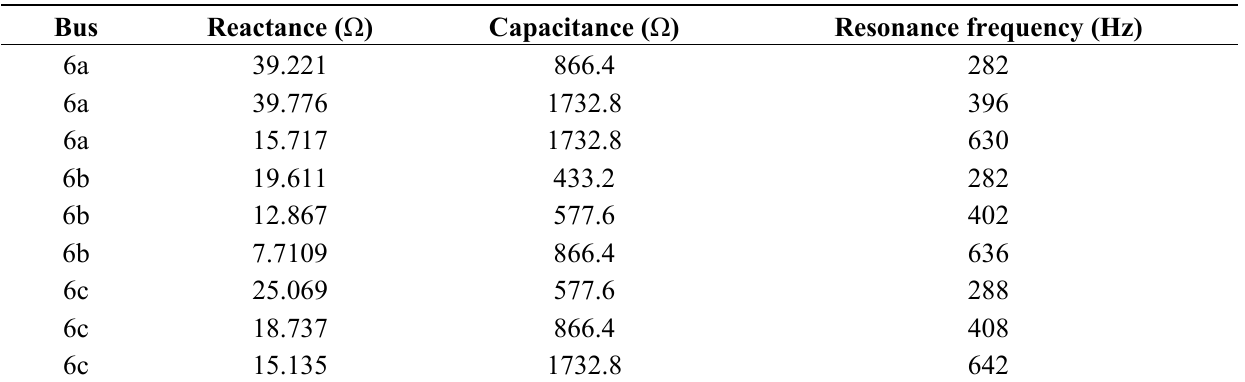
Table 5. Parameters of installed harmonic